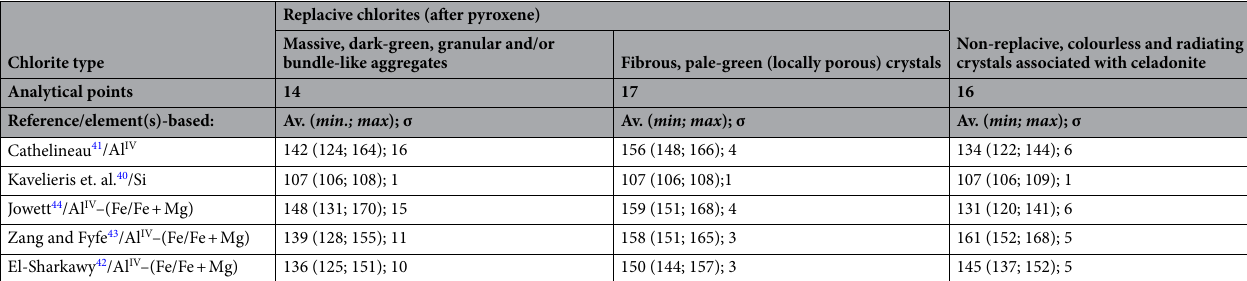
Table 7. Variations of chlorite crystallization temperatures obtained using particular empirical geothermometers. Av.—average value (mean); min.—minimum value; max.—maximum value; σ—standard